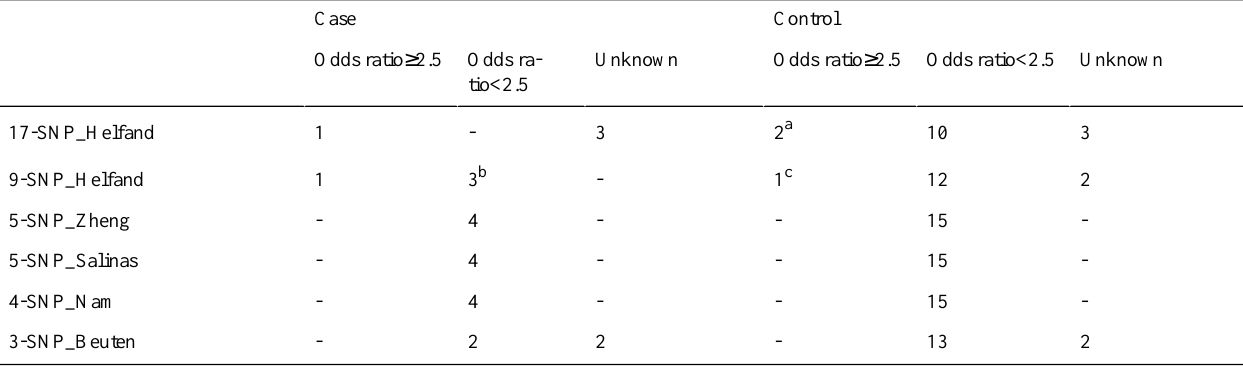
Table 9. Summarized results for cumulative